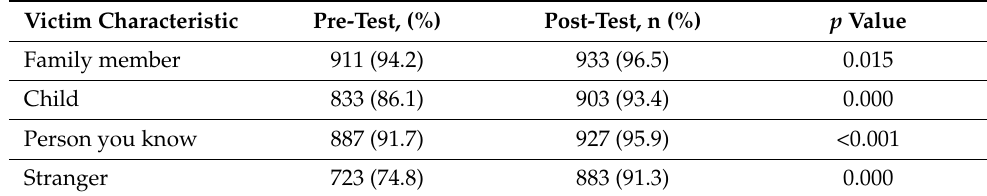
Table 3. Comparison of the pre-test and post-test results on the number of participants (n = 967) who declared that they would undertake CPR on individual victims (family member, child, person you know, stranger) multiple choice question.